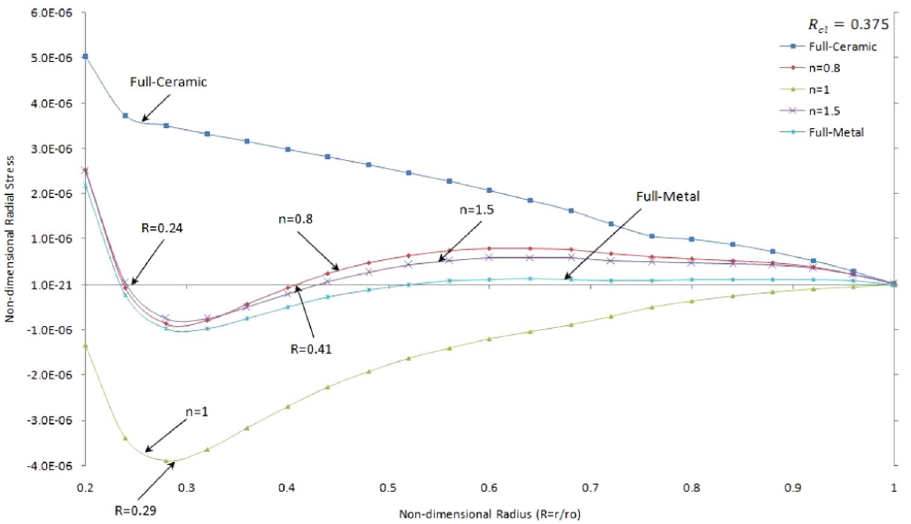
Figure 12. Non-dimensional radial stress versus the non-dimensional radius of two side contacts with temperature-dependent material properties under thermo-mechanical load in the FGMs rotating brake disk with R cl = 0.375 and different values of the grading index,